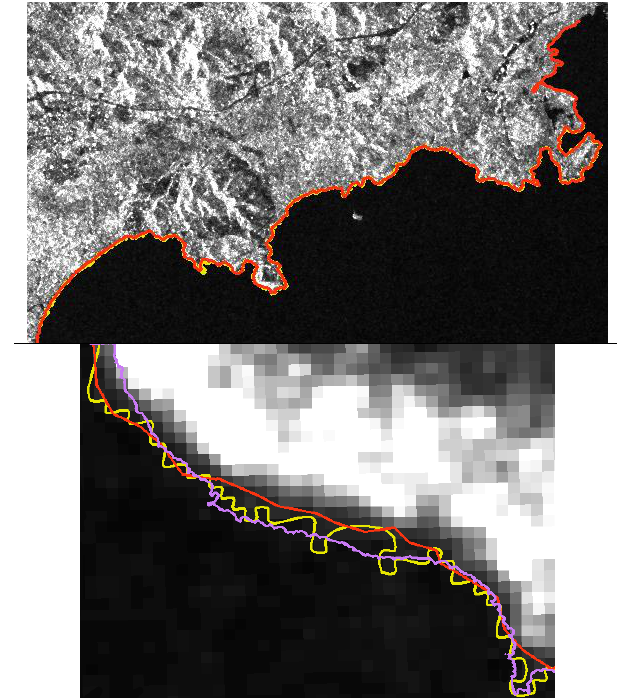
Figure 11. Comparison of the extracted coastlines with reference data (yellow:SAR, Purple :LIDAR, red: manual